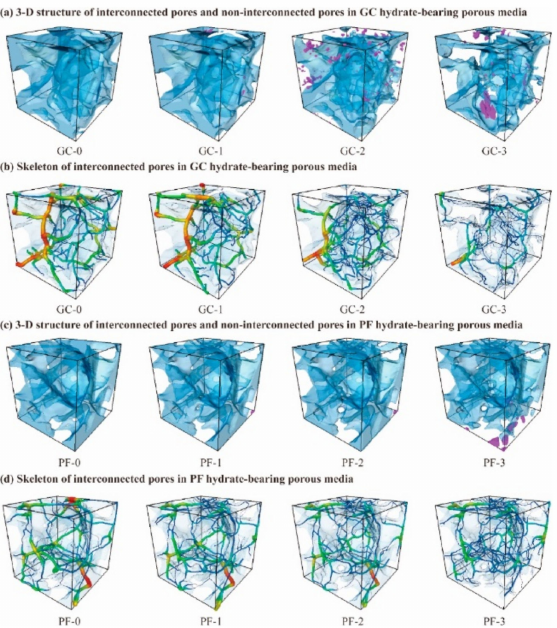
Figure 16. The pore structure of hydrate-bearing porous media reprinted from [103] with permission from Elsevier. ( a , c ) the 3-D structure of effective pores in blue and non-interconnected pores in purple; ( b , d ) the skeleton of effective